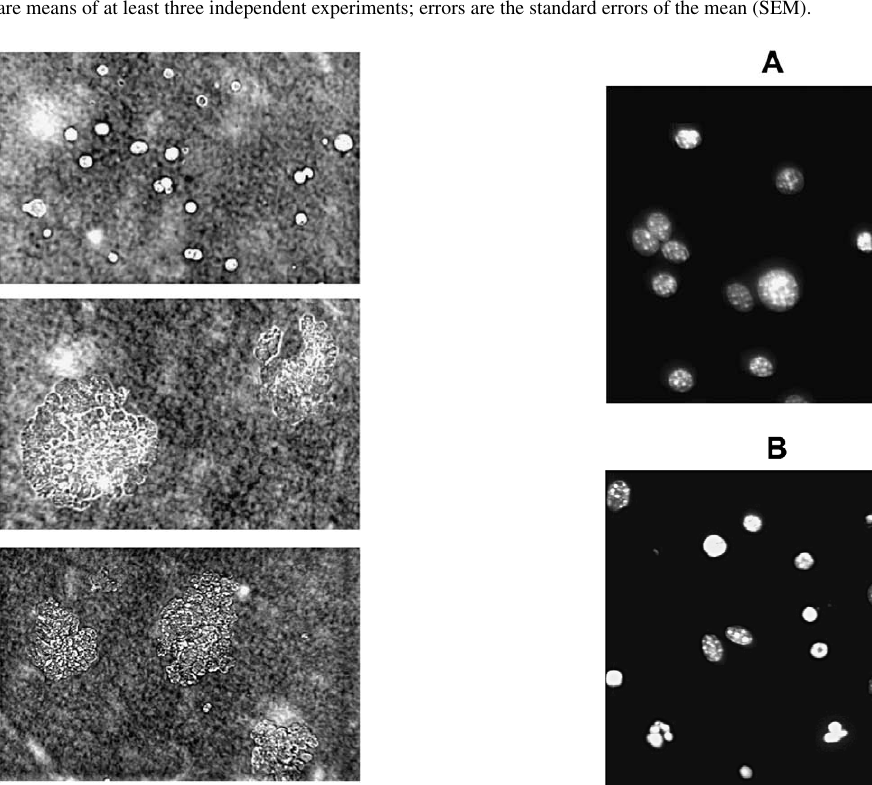
Fig. 3. Cell survival after 4 days of serum starvation, HCV core- expressing clone NIH191-3 (A), and control NIH 3T3 Neo r (B). by serum starvation. In concordance with the data for the in vitro cultured skin fibroblasts [65], cells starved for 1 day showed no significant increase in apoptosis (data not shown). After 3–4 days of starvation, NIH 3T3 Neo r clones began to die exhibiting extensive cell rounding, shrinkage, cytoplasmic blabbing, and chro- matin condensation, while core-expressing cells re- mained alive (Fig. 3). After 6 days, the percentage of apoptotic cells with fragmented/apoptotic DNA ( < 2N) was 31% in NIH 3T3 Neo r , 2 . 5% in NIH191-3, and 7% in NIH191-10 clones (Fig.